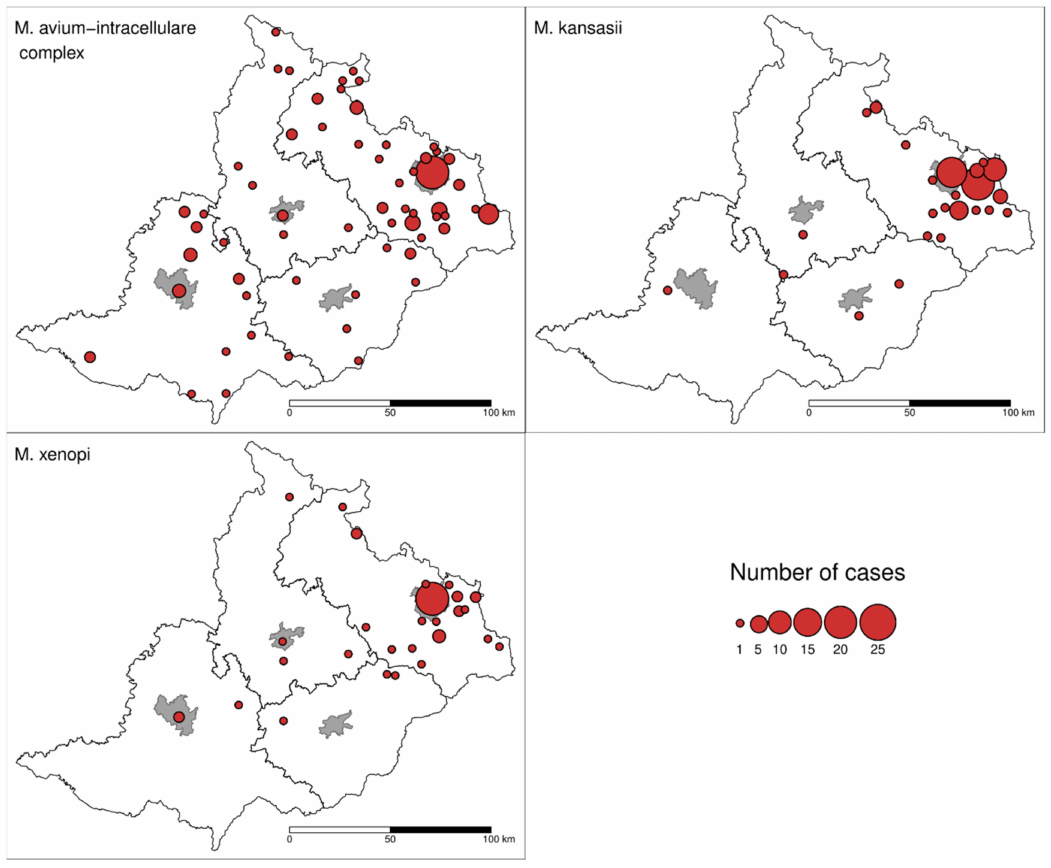
Figure 4. Location and number of patients with the three most frequent NTM species in the studied area during the period